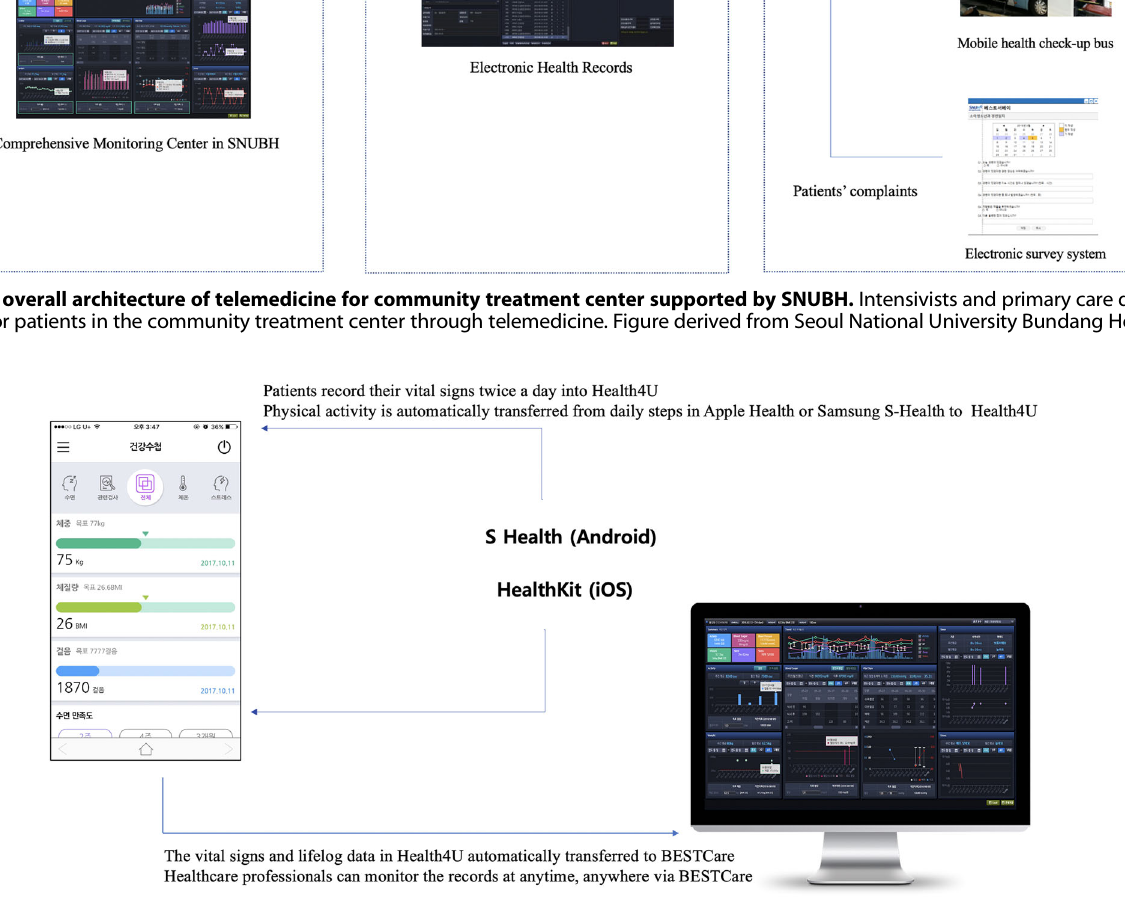
Fig. 4 The overall process of integrating vital signs from Health4U to BESTCare. Patients in the community treatment center can integrate vital signs through Health4U to BESTCare. Figure derived from Seoul National University Bundang